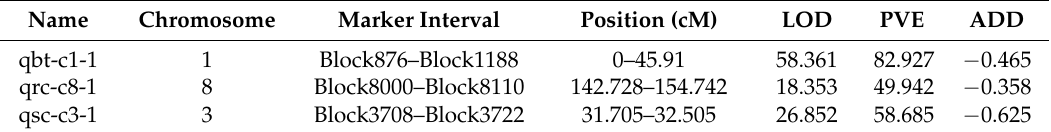
Figure 6. Mapping results for fruit bitterness, seed coat color, rind color on watermelon linkage groups 1, 3 and 8. Bin marker names and map distance in centimorgans (cM) are shown on the right side of each linkage group. Table 3. Loci associated with fruit bitterness, rind color, and seed coat color.